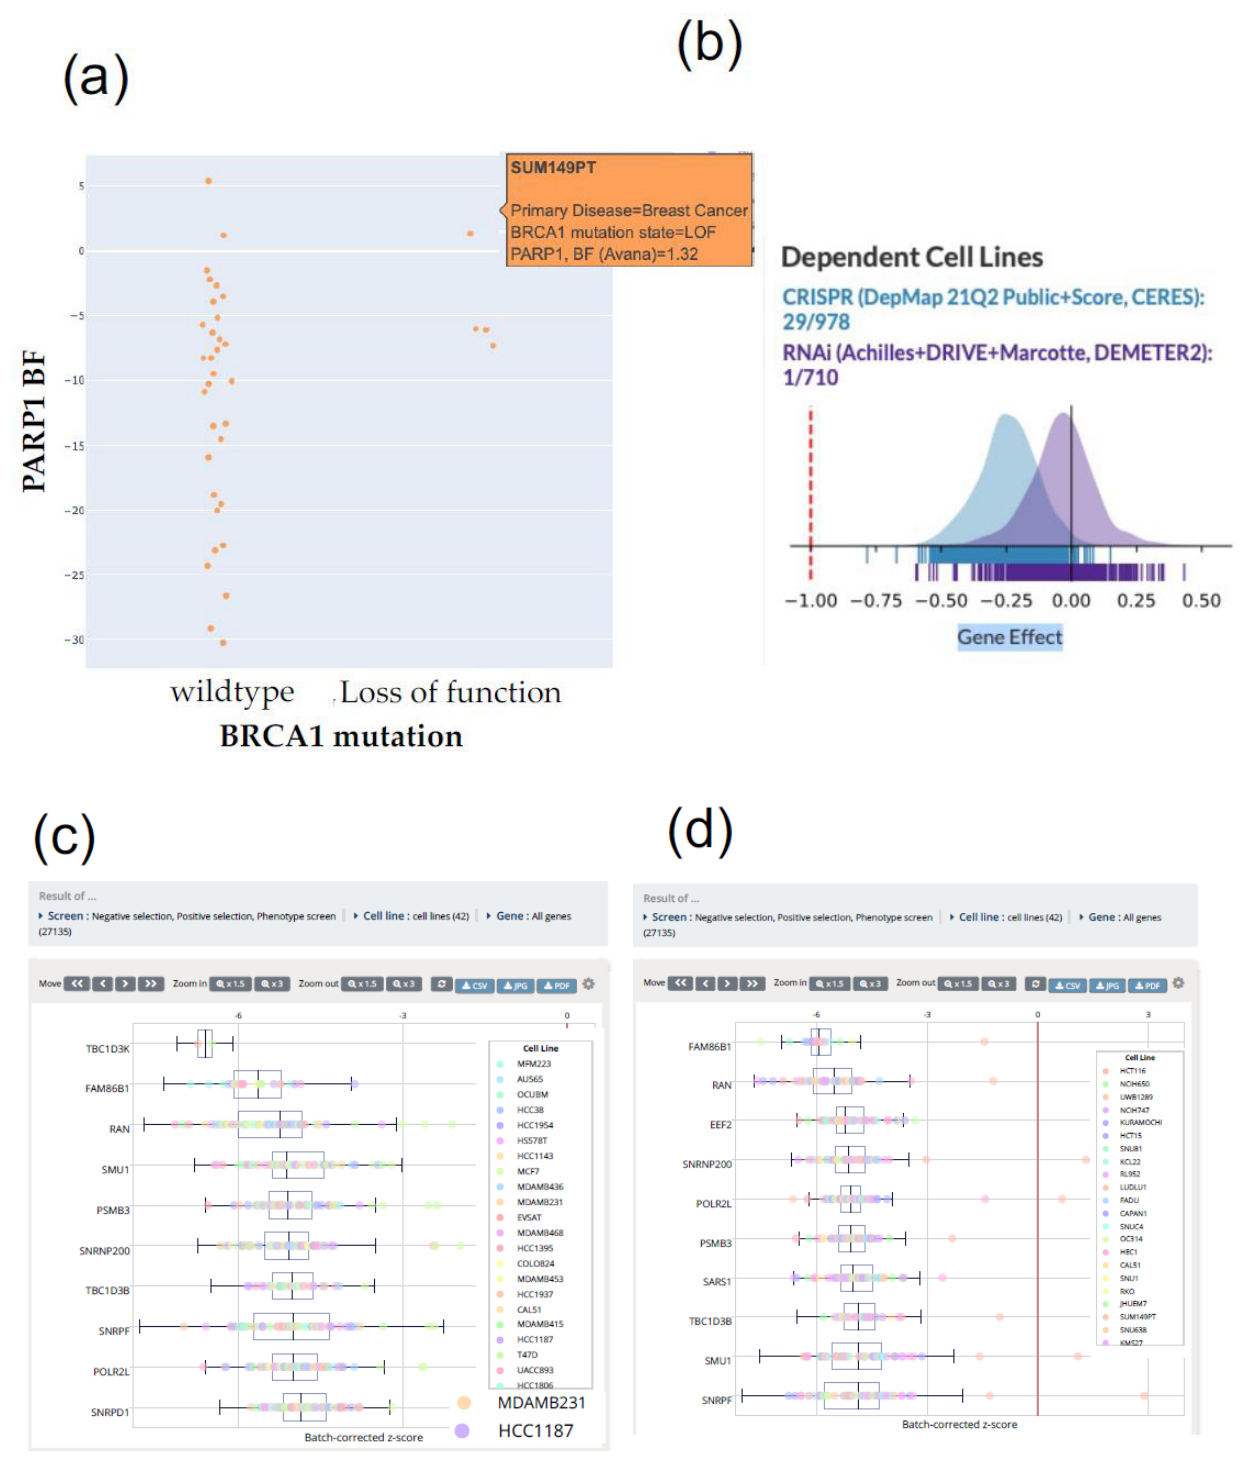
Figure 2. CRISPR library database. ( a ) Result of BRCA1 mutation and PARP1 BF from PICKLES (http://pickles.hart-lab.org (accessed on 24 October 2021)). BRCA loss-of-function cell lines are dependent on PARP1 compared with BRCA wild-type cell lines. BF: Bayes factor ( b ) PARP1-dependent cell line from Depmap portal (https://depmap.org/portal/ (accessed on 24 October 2021)). Depmap’s “Dependent Cell Lines” category suggests that a chosen gene is a ‘common essential’ or ‘strongly selective’ judgment for cell lines regarding CRISPR and RNAi database. Because searching ‘ PARP1 ′ in Depmap showed no judgment in the “Dependent Cell Lines” category, PARP1 is not an essential gene for most cell lines and not- selective drug targets. ( c ) Top essential genes of the breast cancer cell lines from iCSDB (https://www.kobic.re.kr/icsdb/